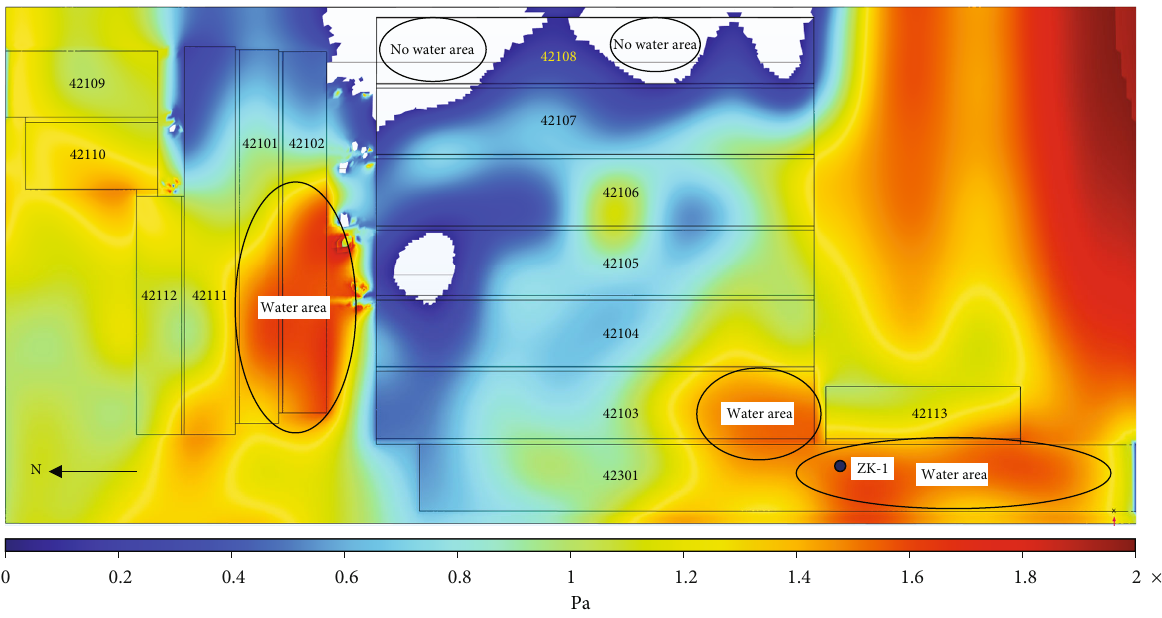
Figure 10: Cloud diagram of the pressure distribution on the fl oor of the goaf in No.